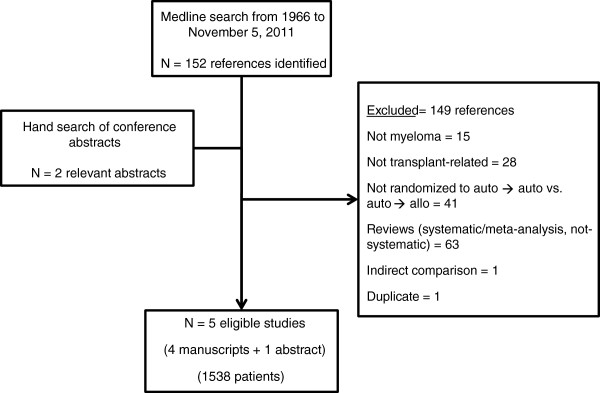
Flow-diagram depicting the identification and selection of eligible studies for inclusion in the systematic review.